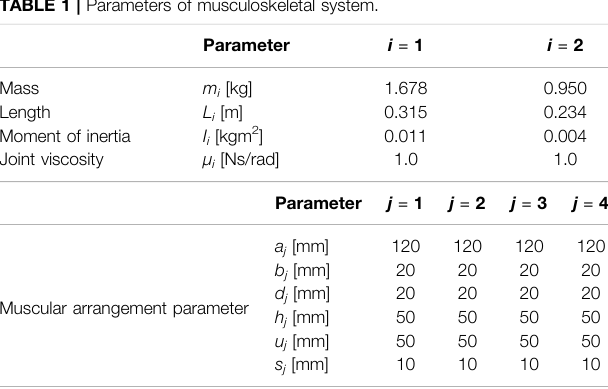
TABLE 1 | Parameters of musculoskeletal system.